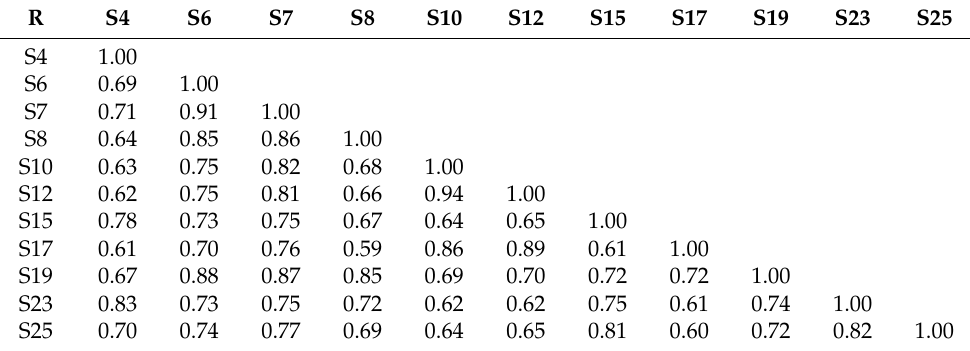
Table 4. Correlation matrix of all PM 10 data recorded by all sensors.